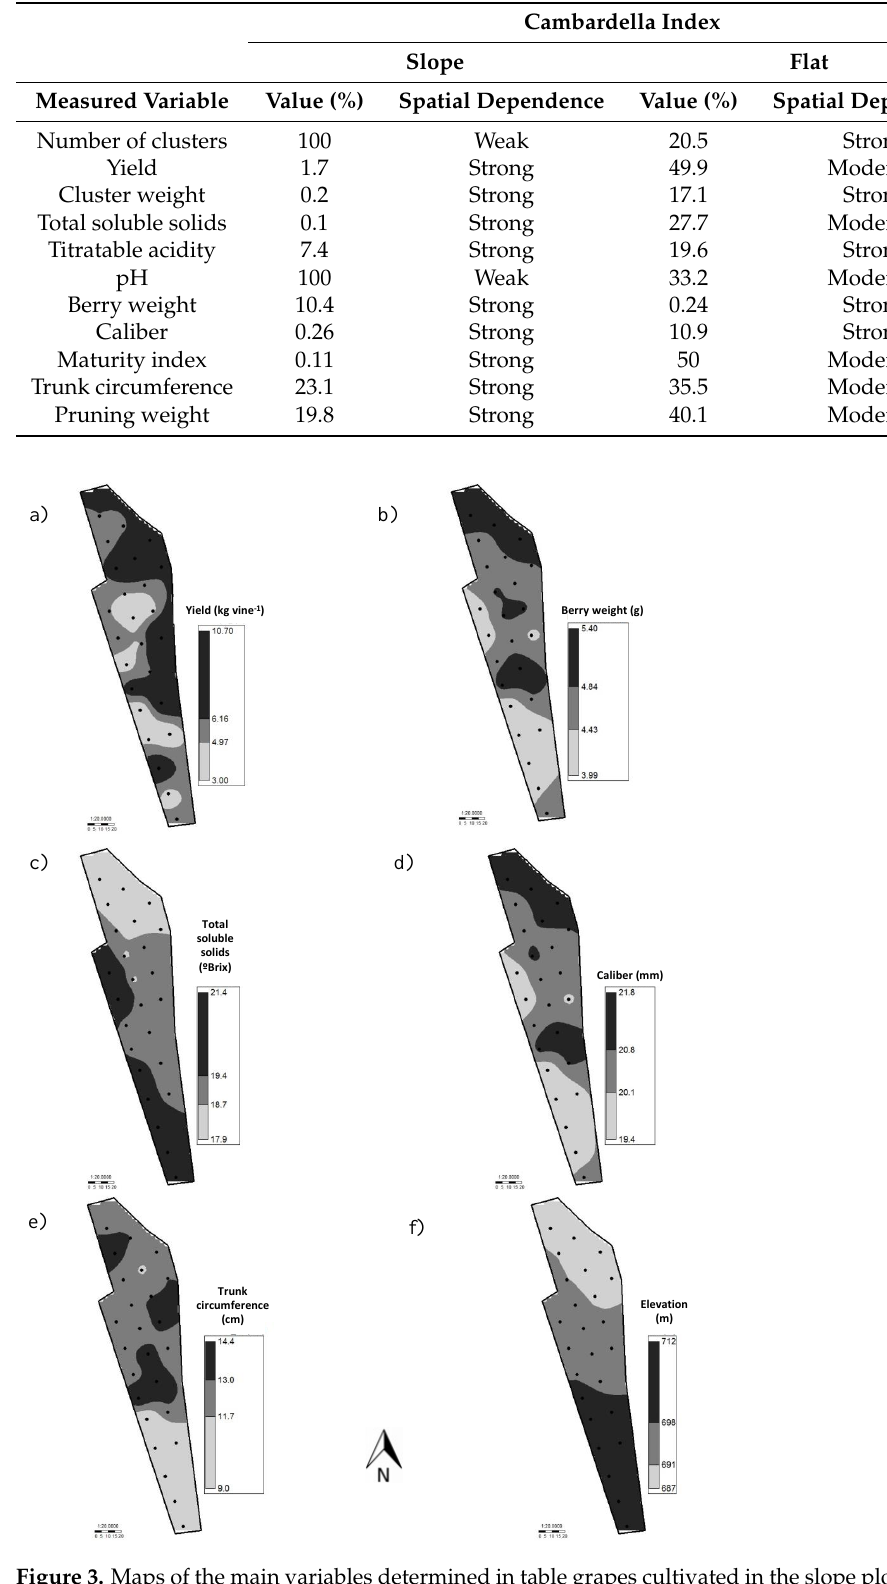
Table 5. Spatial dependence (Cambardella index) of the measured variables in the plots under study.